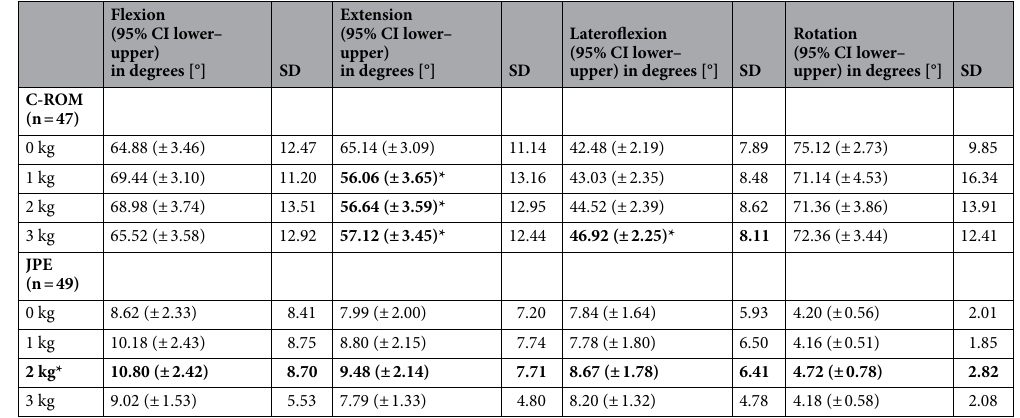
Table 1. Absolute means of the ROM and JPE values in degrees by 0-, 1-, 2- and 3-kg axial loading. C-ROM cervical range of motion, JPE joint position error, 95%-CI 95% confidence interval, SD standard deviation, kg kilogram, ° degrees, * significant (p < 0.05).